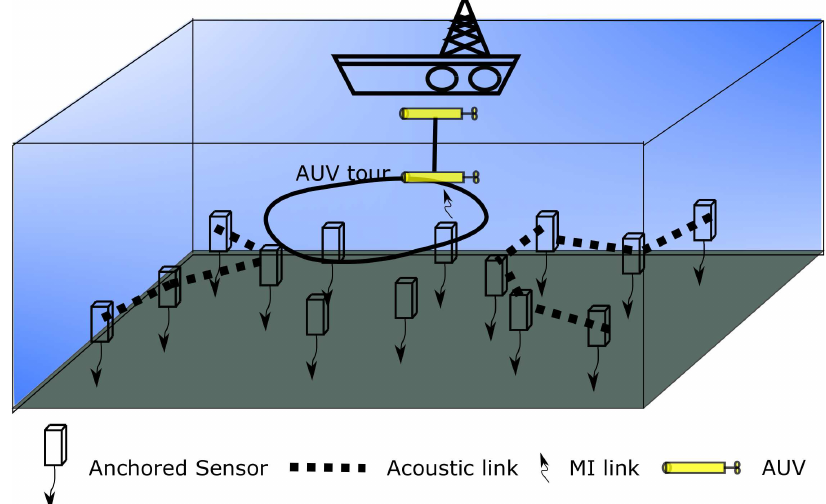
Figure 1. AUV(autonomous underwater vehicles)-aided data